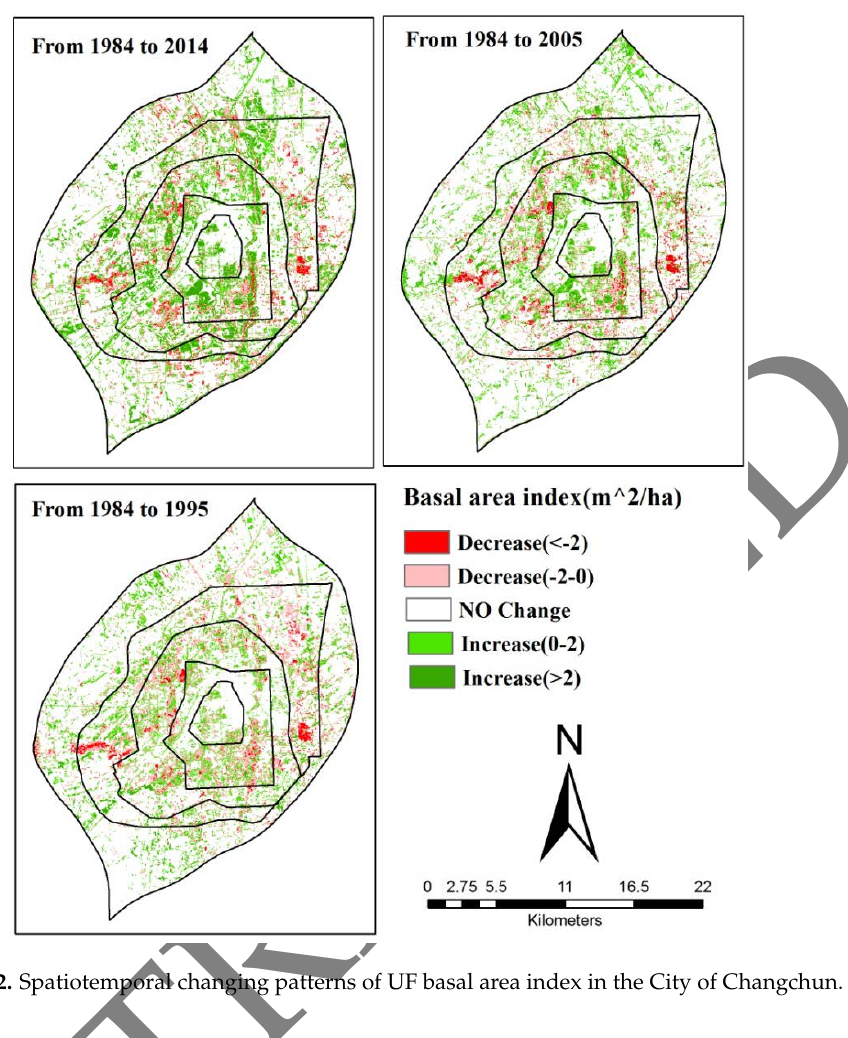
Figure 12. Spatiotemporal changing patterns of UF basal area index in the City of Changchun.